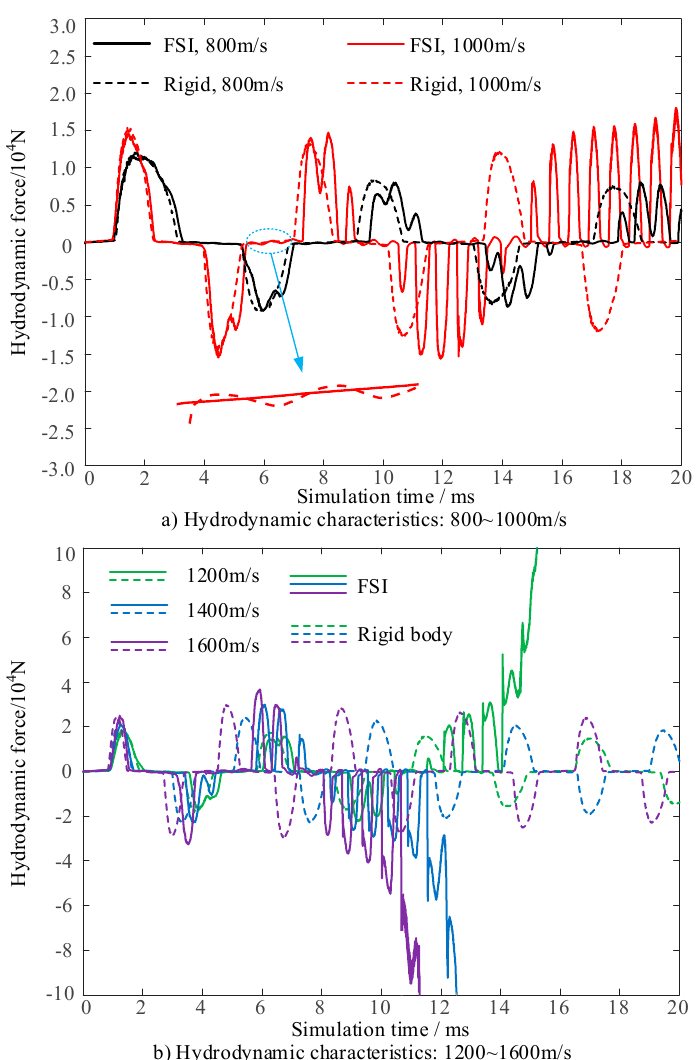
Figure 11. Influence of FSI effect on hydrodynamic characteristics under different initial speeds. ( a ) Hydrodynamic characteristics: 800~1000m/s ( b ) Hydrodynamic characteristics: 1200~1600m/s.